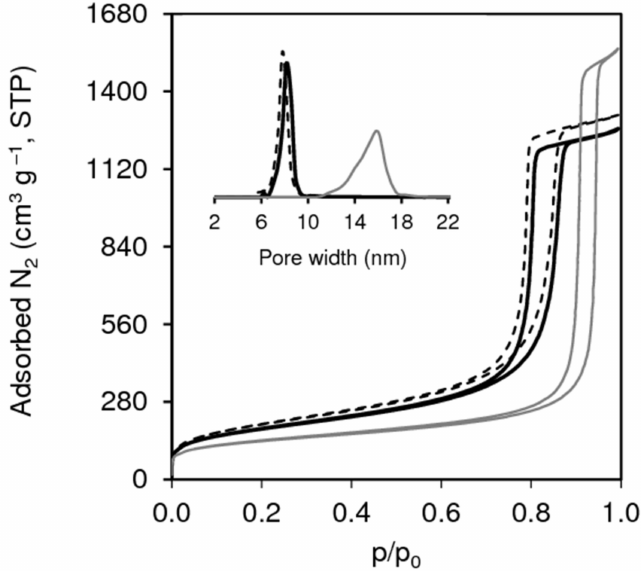
Figure 2. Nitrogen sorption isotherms at − 196 ◦ C of Hf-TUD-1(75) (grey solid line), Hf-TUD-1(50) (black solid line) and Hf-TUD-1(25) (black dashed line). Inset shows the corresponding mesopore size distributions (using the same lines and